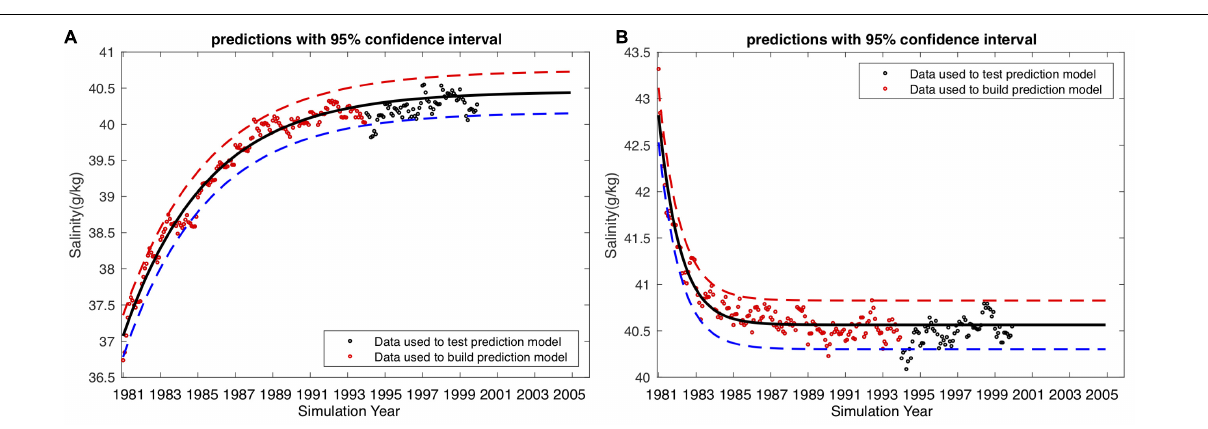
FIGURE 10 | Exponential model to fit basin-average salinity in D1a (A) and D1b (B) experiments. GARM simulation results from 1981–1993 (red dots) are used to build the regression model, while results from 1994–1999 (black dots) are used to test the predictive capability of the regression